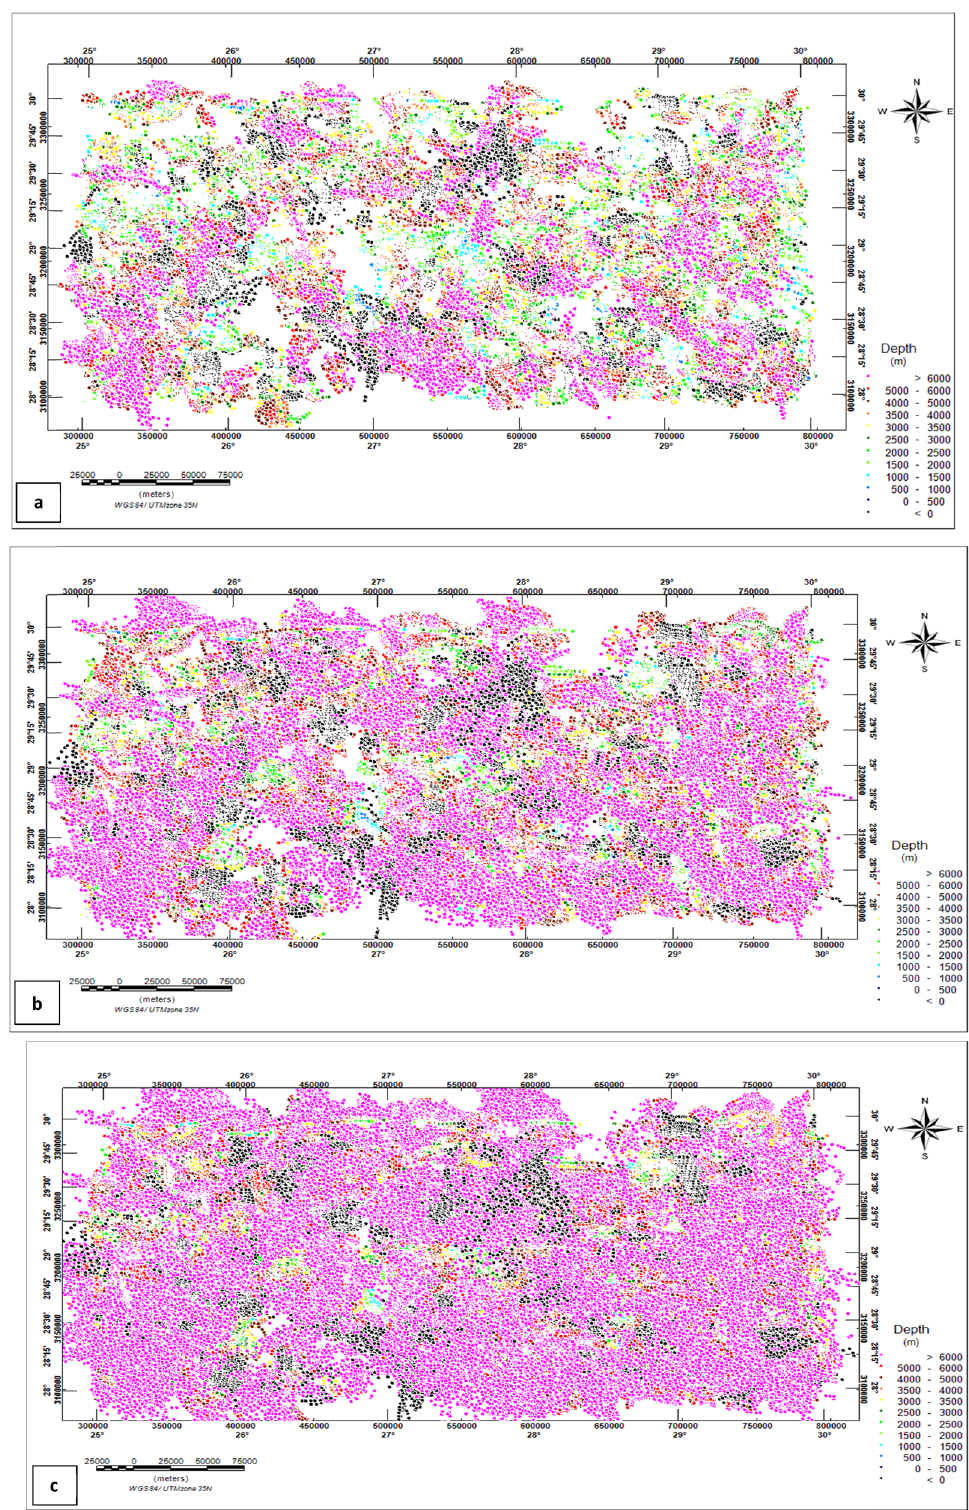
Figure 9: Euler solutions of structural index: ( a ) = 1, ( b ) = 2, ( c ) =